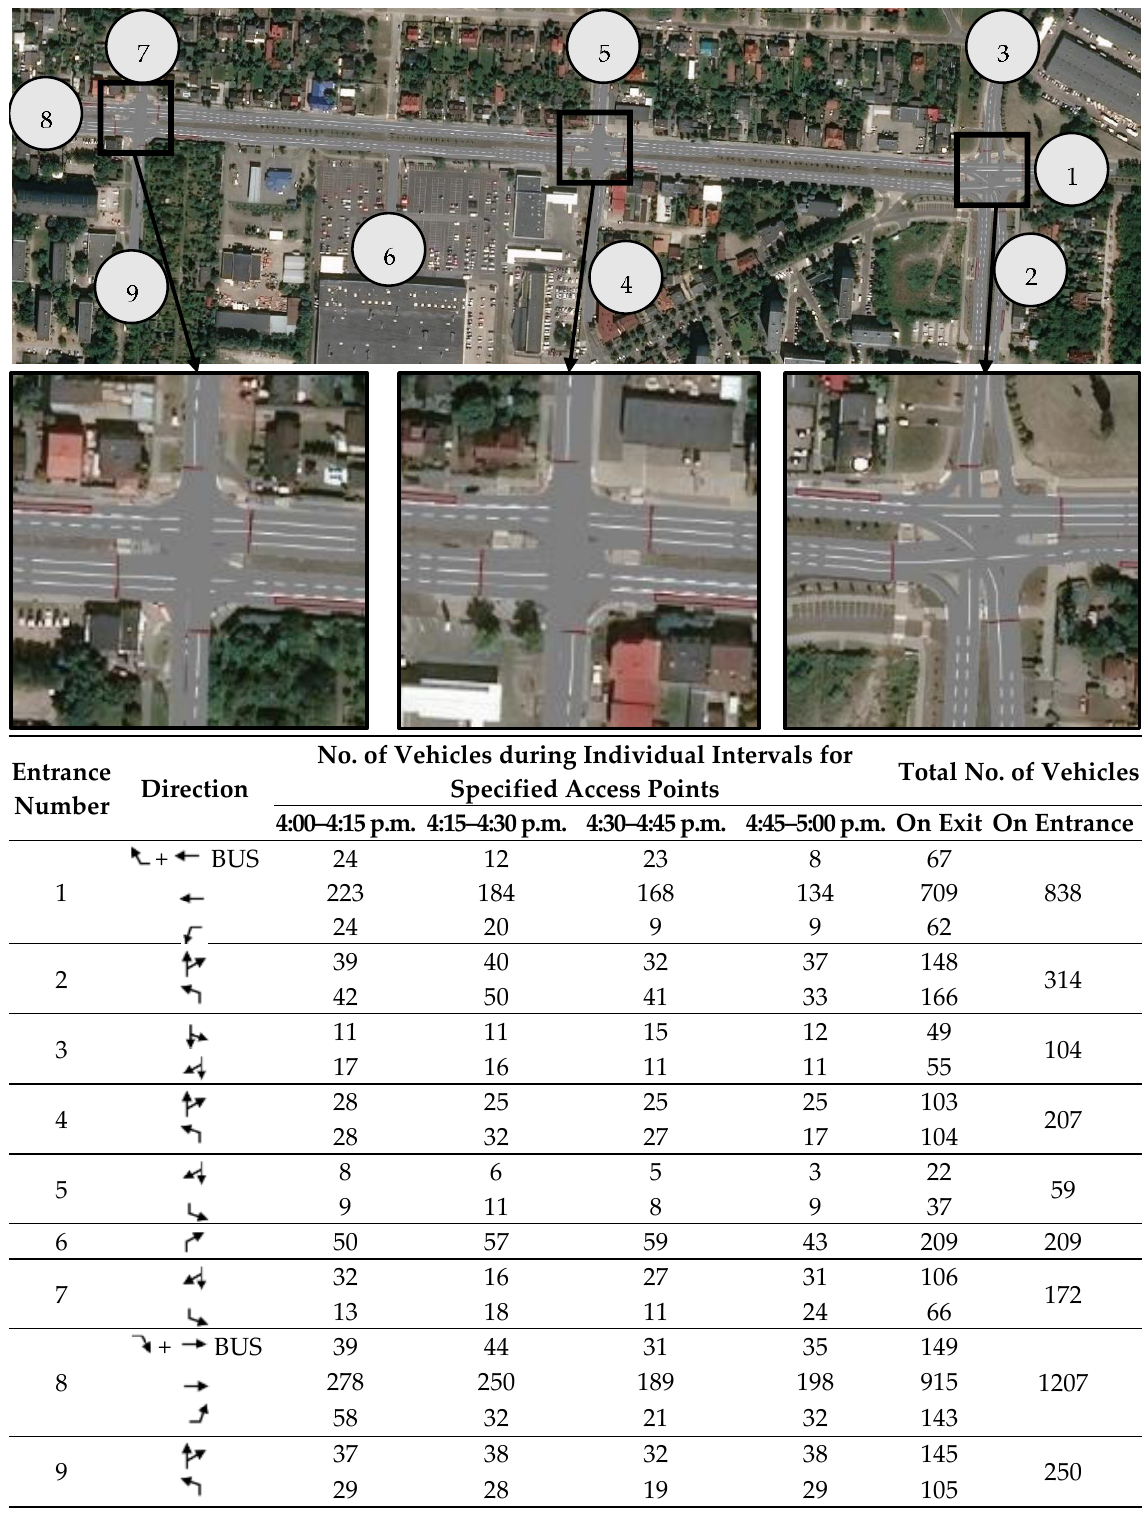
Figure 7. Model of the applied network and the number of vehicles for individual entrances. The authors utilised the Wiedemann-74 car-following model for the applied traffic structure, which was divided into bus, car, and HGV. For the first group, the model determined the time when a given bus appeared within the analysed part of the network, based on the timetable details provided. During the field inventory, it was